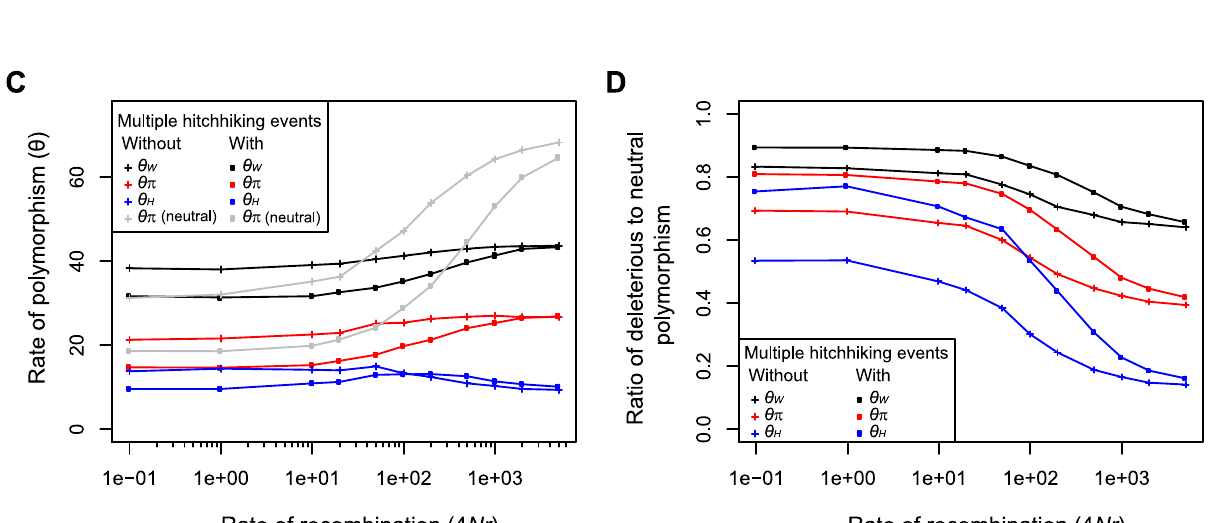
identified by all nine tests of selection. The increase in the ratio of deleterious to neutral SNPs in hitchhiking regions is due to a decrease in the number of neutral SNPs rather than an increase in the number of deleterious SNPs (Figure 3B and 3C). With the exception of the composite likelihood ratio test (CLR) [34], all of the methods used to detect hitchhiking identify regions with a higher ratio of deleterious to neutral SNPs (Figure 3D). Thus, the increase in the relative abundance of deleterious SNPs in hitchhiking regions does not appear to be associated with any specific test of selection.